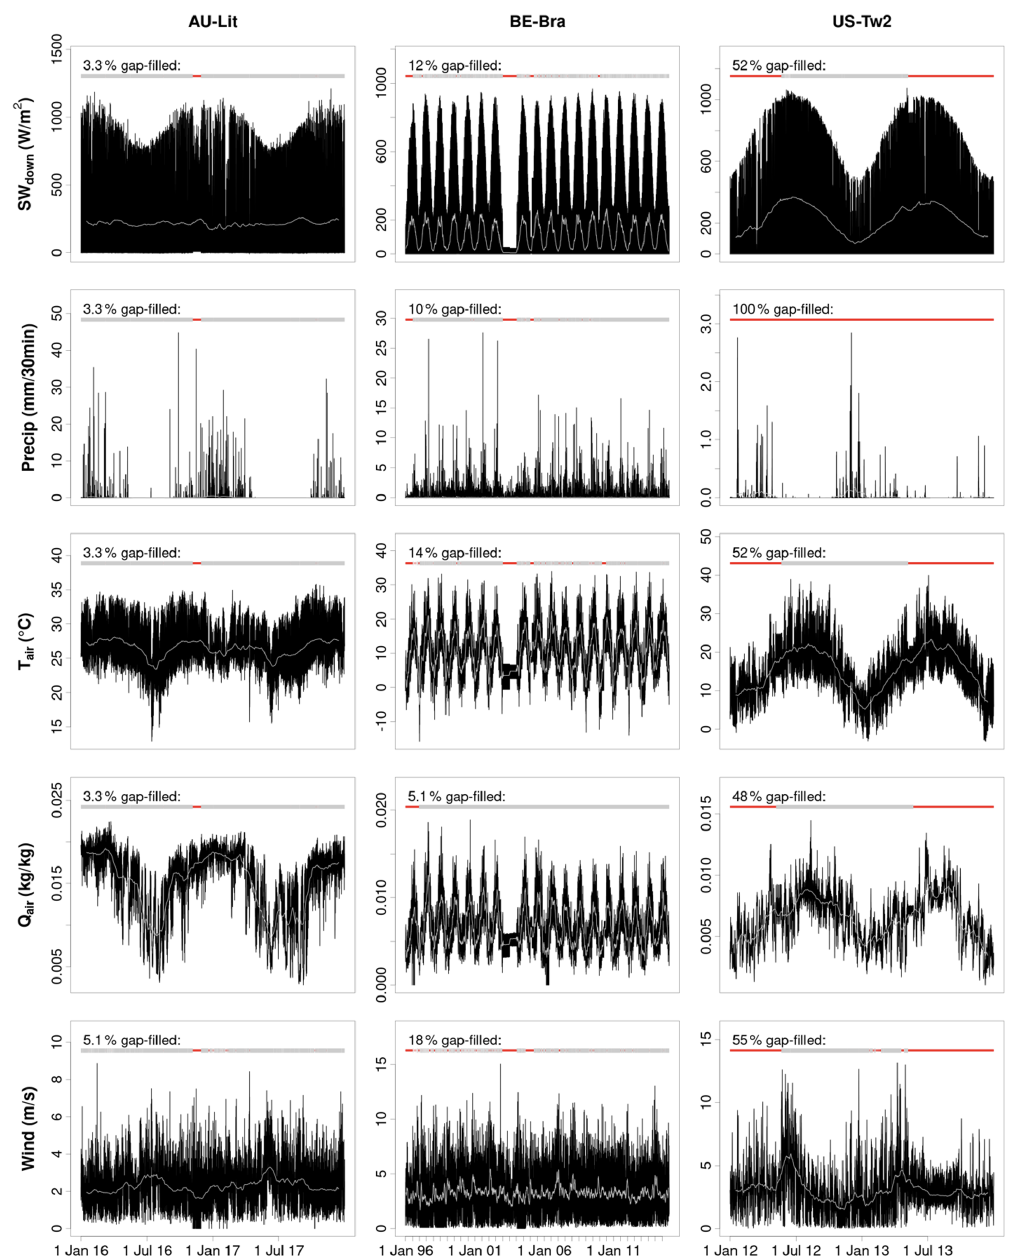
Figure 2. Examples of meteorological data pre-screening plots for three sites (AU-Lit, BE-Bra, and US-Tw2). For each site different pro- cessing approaches were used and sections of these data